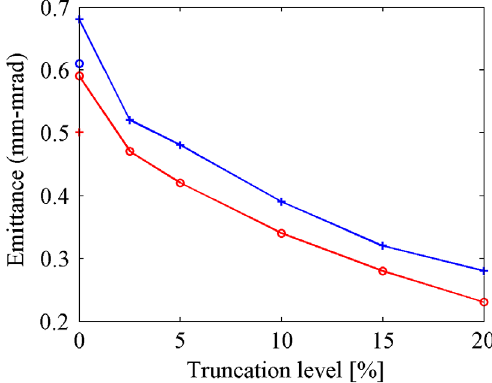
FIG. 26. Emittance calculated from the horizontal data (rms with area cut) shown in Fig. 28. after deconvolving the optics system resolution: (a) beam size versus quadrupole strength fits with the data corrected for various resolution contributions and (b) the resulting emittances versus the resolution.